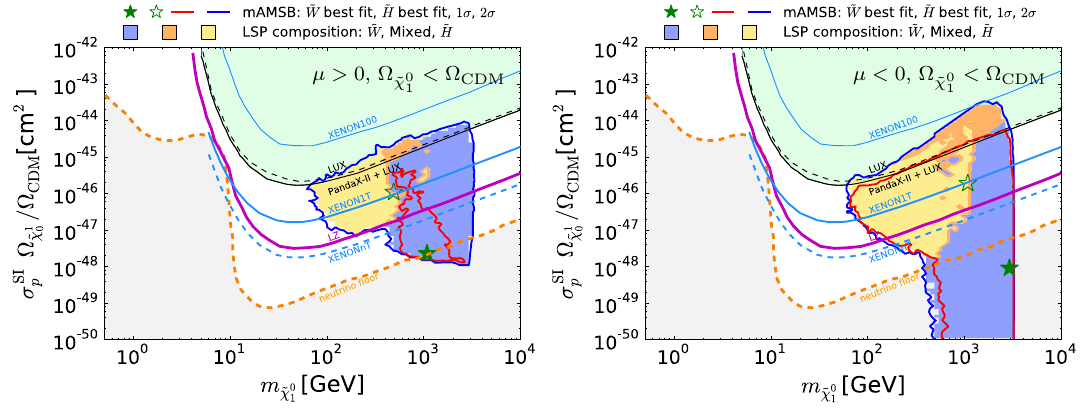
,σ SI ) planes in the mAMSB for μ > 0 ( left ) and μ < 0 ( right ) in the case when the LSP only accounts for a fraction of the Fig. 27 The ( m ˜ χ 0 p 1 CDM density. The legends, line styles and shadings are the same as in Fig.